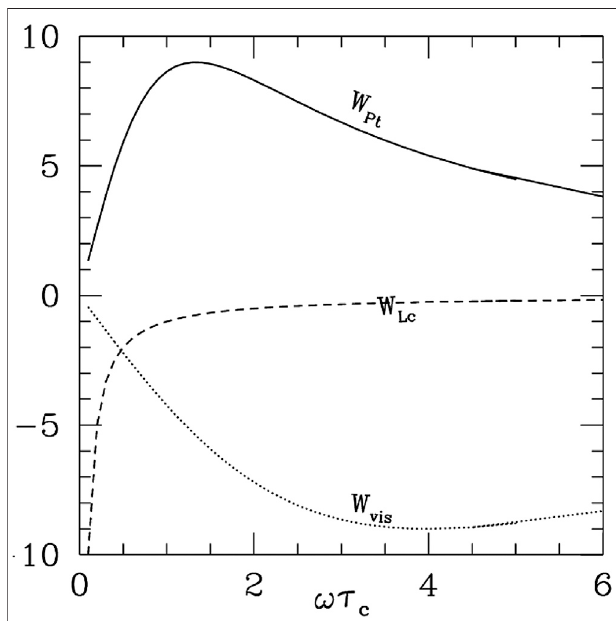
FIGURE 9 | Frequency dependence of the excitation and damping effects of turbulent pressure (solid line), turbulent viscosity (dotted line), and convective enthalpy fl ux (dashed line) on stellar oscillations. The ordinate is used in any unit.